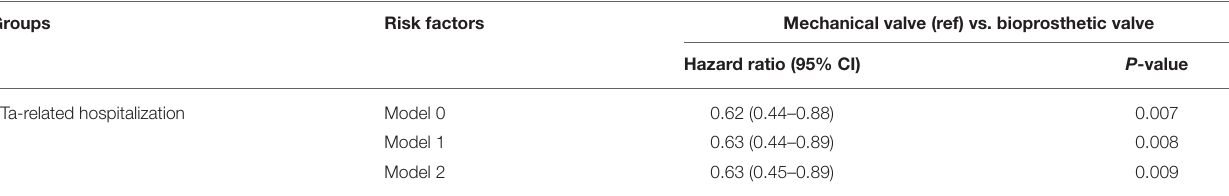
TABLE 3 | Comparison of risk of ventricular tachyarrhythmias between bioprosthetic and mechanical valve replacement. Groups